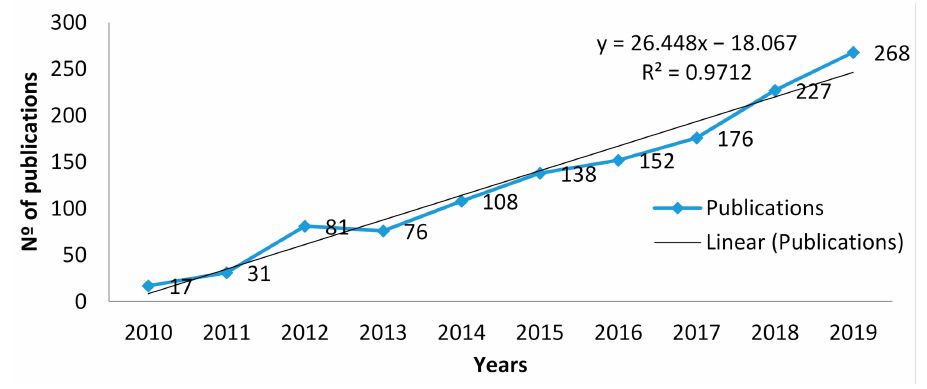
Figure 1. Scientific production on adolescent cyberbullying and its trend from 2010 to